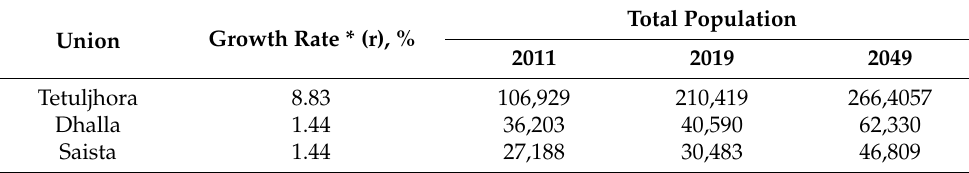
Table 6. Projected population in the selected peri-urban areas around Dhaka. Union Growth Rate * (r), %